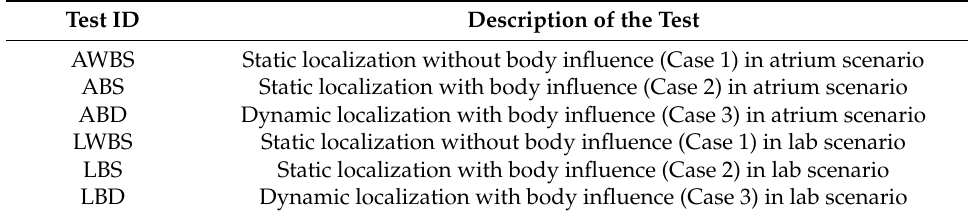
Table 2. Acronyms used to refer the sample sets used for localization algorithms evaluation and comparison. Test ID